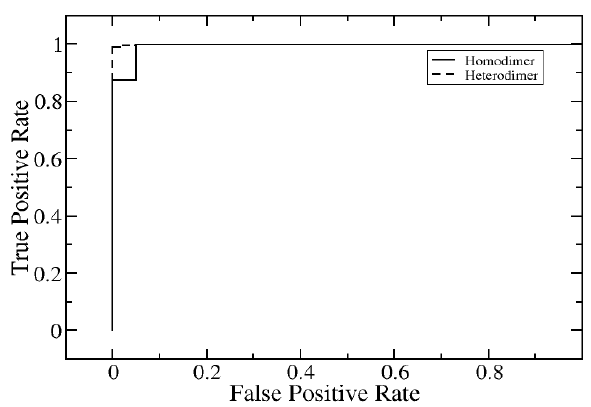
Figure 7. Prediction of disruptive and non-disruptive mutations for homodimer and